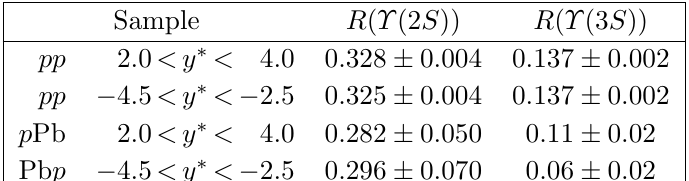
Table 3 . Ratio R ( (cid:7) ( nS )) in pp , p Pb, and Pb p samples. The uncertainties are combinations of statistical and systematical components.